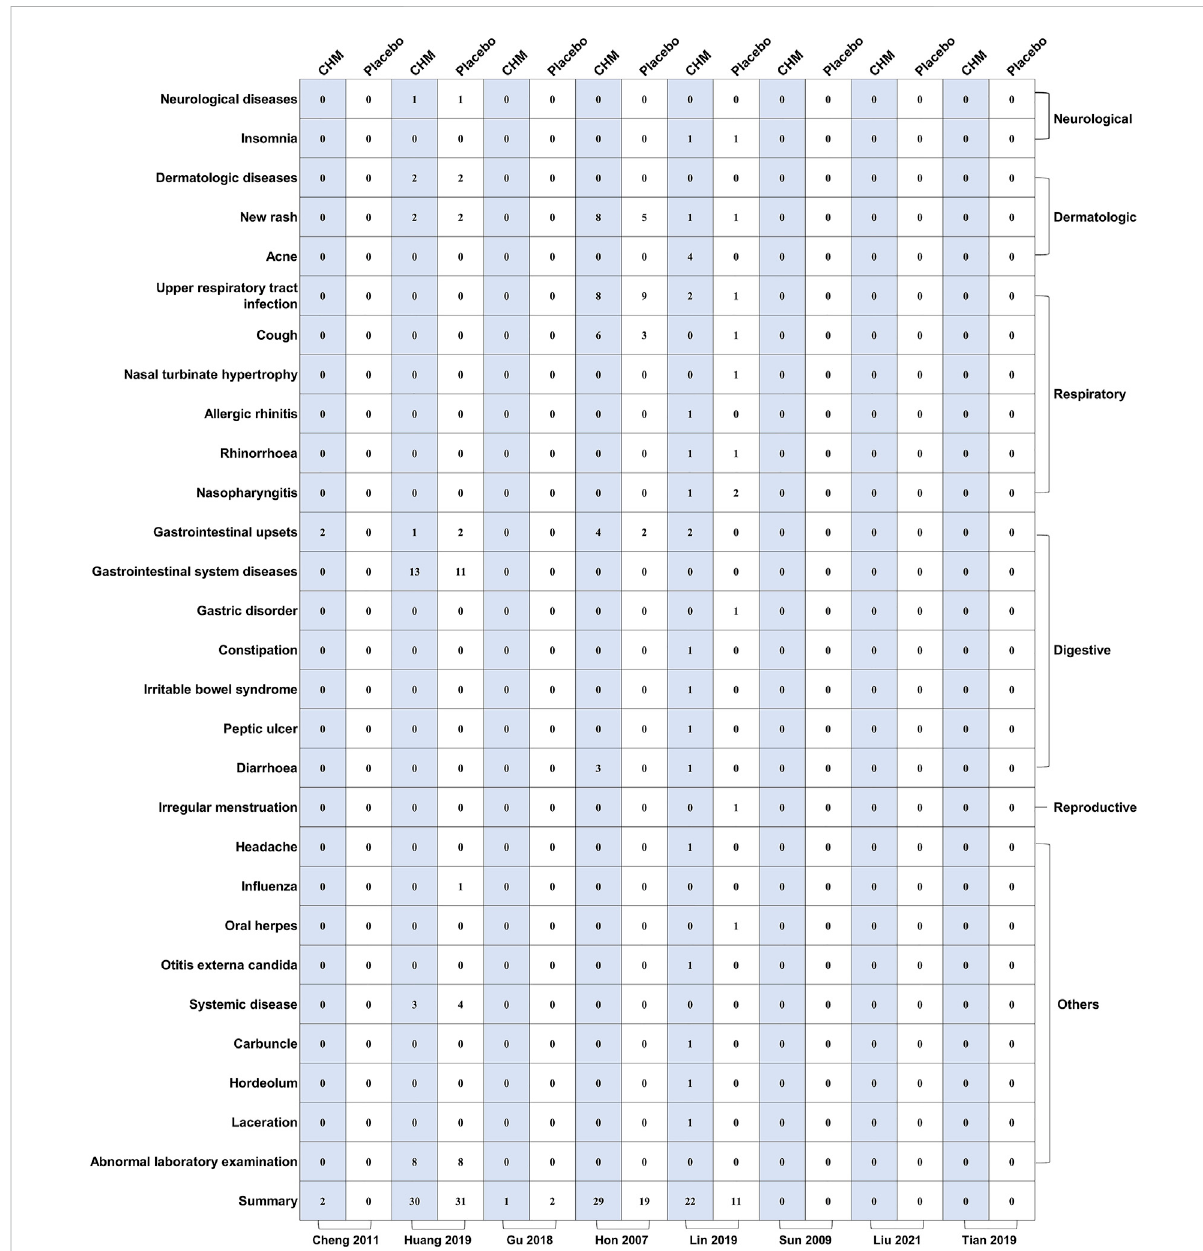
FIGURE 2 The mapping of speci fi c adverse events between biological agents and control groups. MTX: methotrexate.